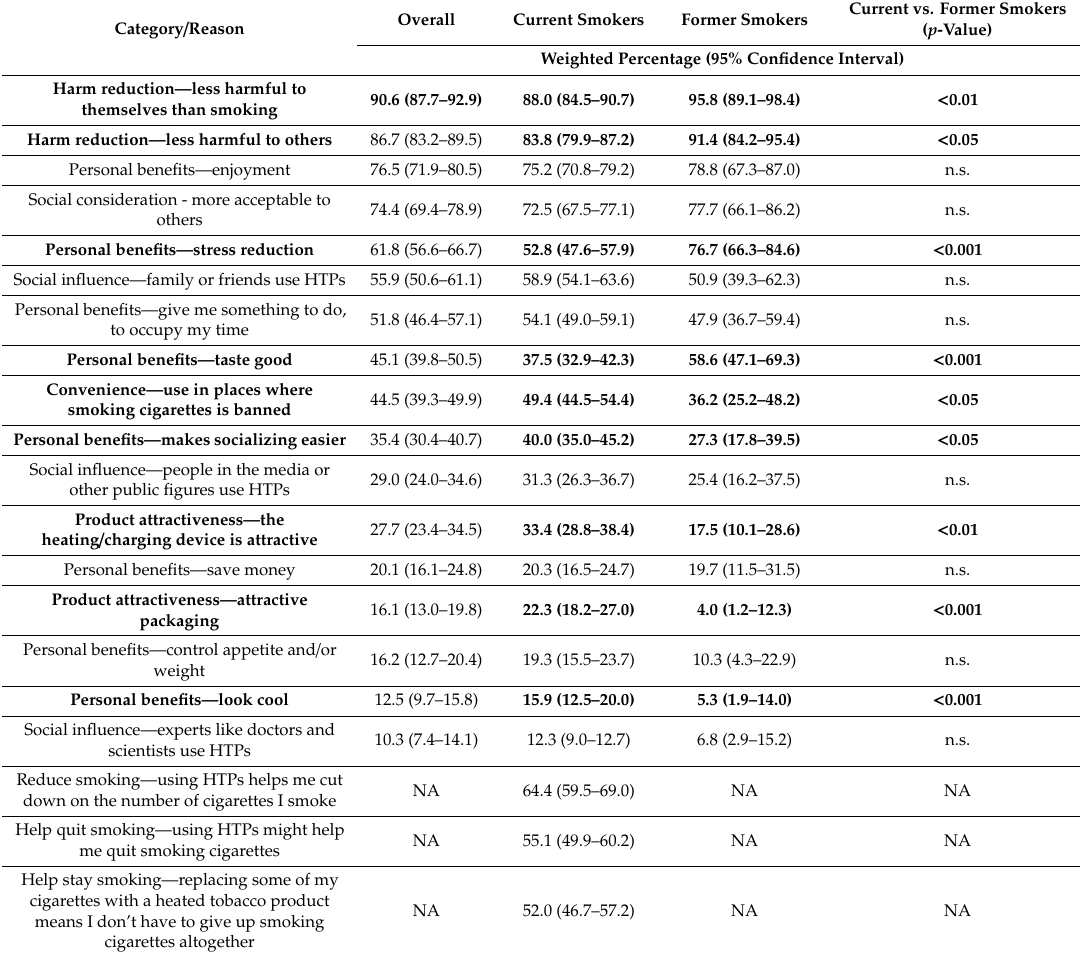
Table 3. Reasons for using HTPs among current and former smokers in order of